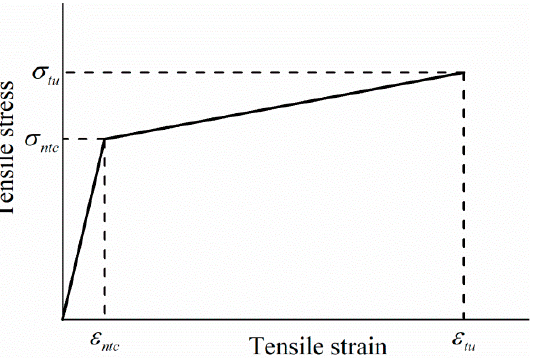
Figure 14. Simpli fi ed two-stage model of tensile stress–strain relationship for HDC. Figure 14. Simplified two-stage model of tensile stress–strain relationship for Based on the characteristics of the HDC tensile stress–strain curve, it is simpli fi ed